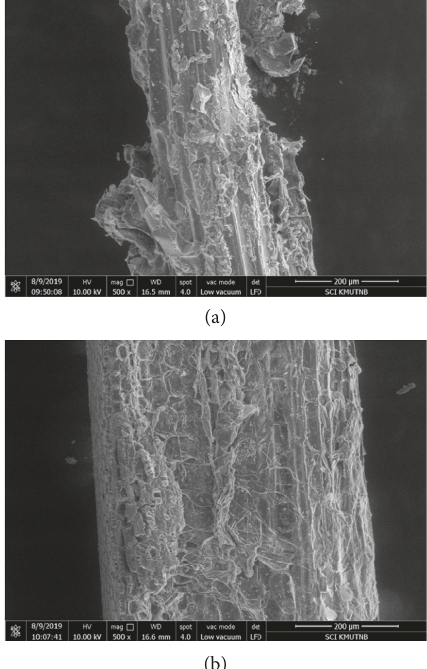
Figure 13: Surface morphology of modified bagasse: (a) before and (b) after the adsorption of